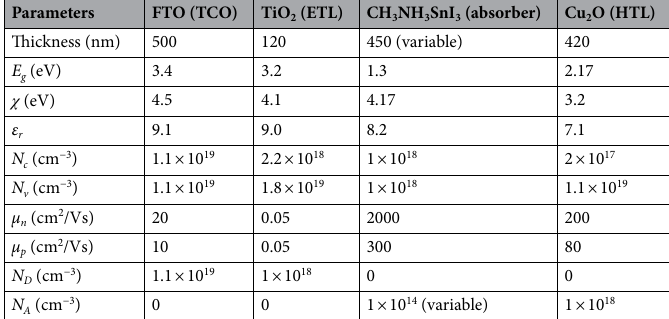
Table 1. Parameters for the optoelectronic simulation.